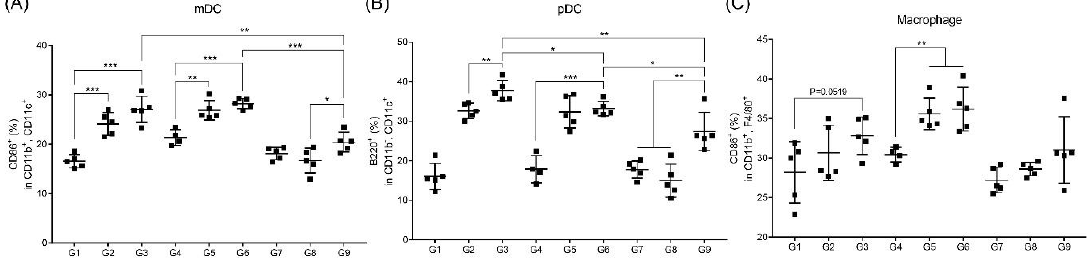
Figure 4. RNA adjuvant activates APCs, particularly dendritic cells (DC). ( A ) Activated myeloid DCs (mDC) (CD11b+CD11c+CD86+), ( B ) plasmacytoid DCs (pDC) (CD11b-CD11c+B220+), and ( C )